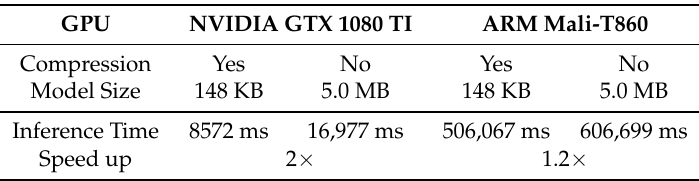
Table 3. Inference speedups by model compression (Lenet-5,